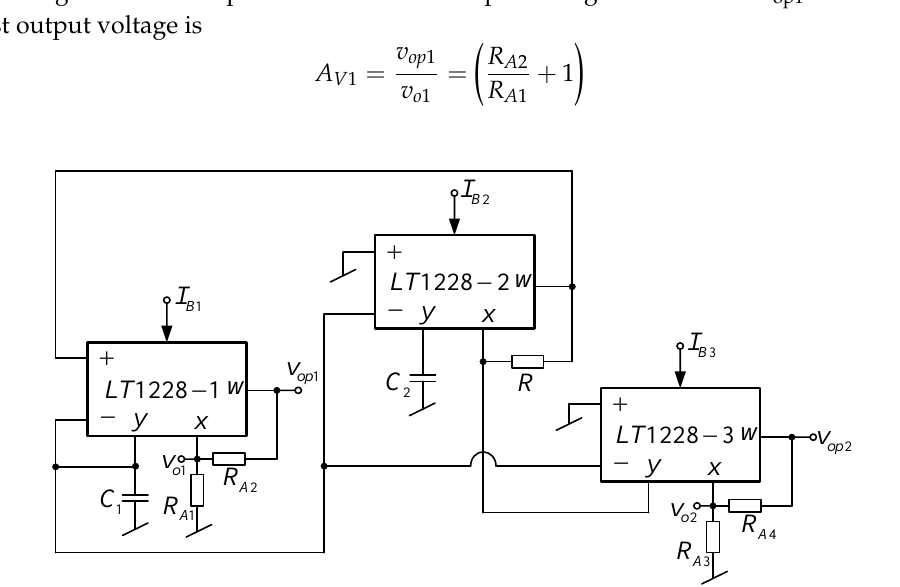
Figure 5. Proposed quadrature sinusoidal oscillator with gain controllability of quadrature output.